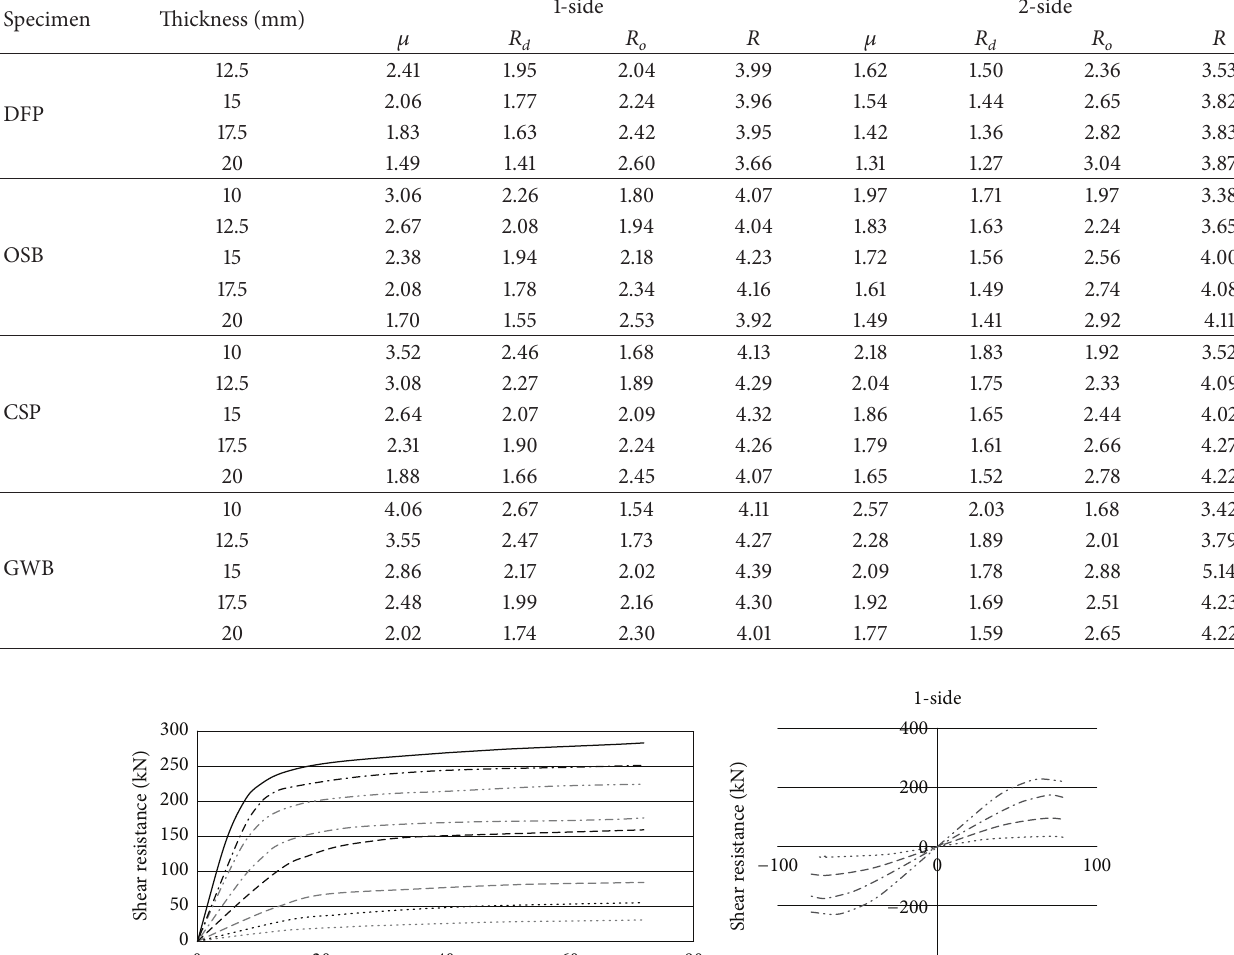
Table 8: The evaluated seismic parameters of sheeting walls ( 𝐻/𝐿 = 1 ).